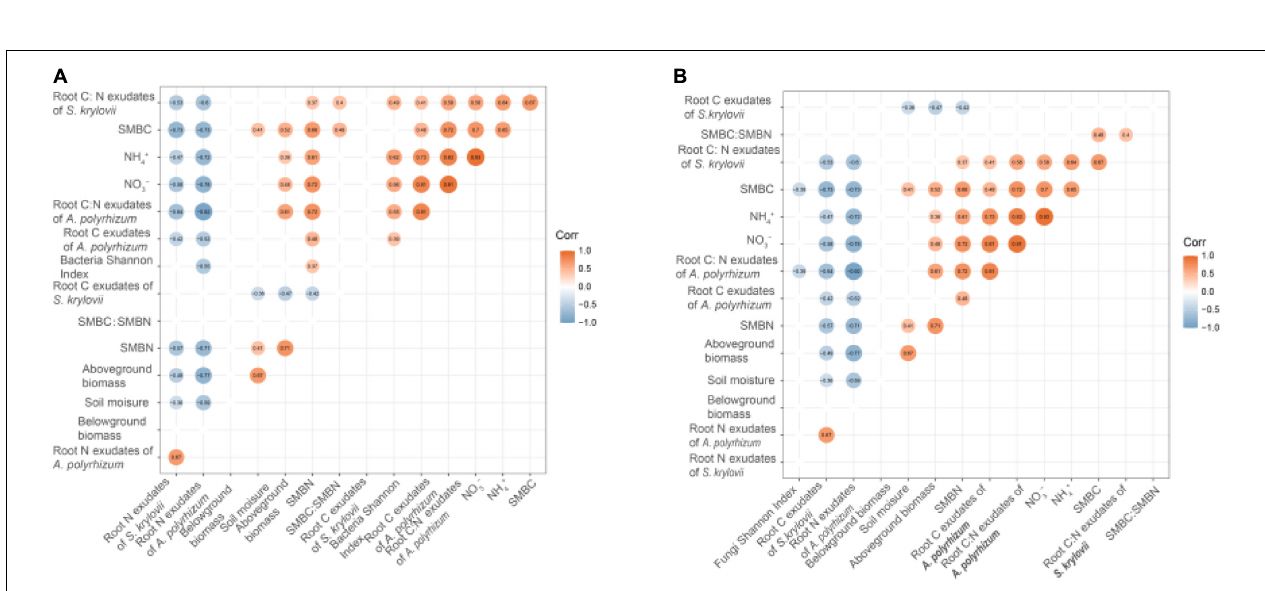
Frontiers in Microbiology |